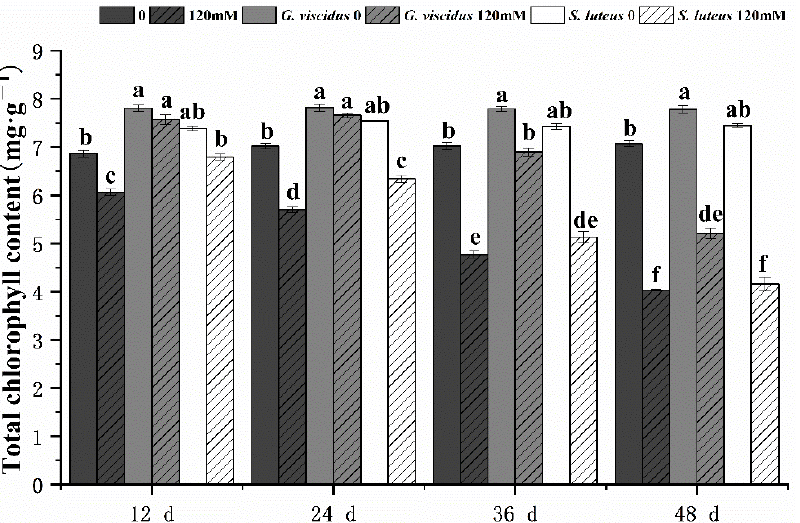
Figure 3. Changes in the total chlorophyll content in ectomycorrhizal seedlings of Q. mongolica under NaCl stress. Bars represent means of five replicates ( ± SD). For each parameter, bars with different letters indicate significant differences among treatments, p ≤ 0.05, following one-way ANOVA.